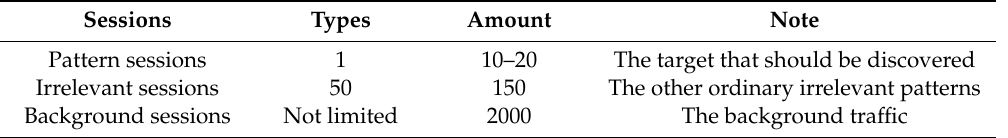
Table 8. The heterogeneous dataset for analyzing.